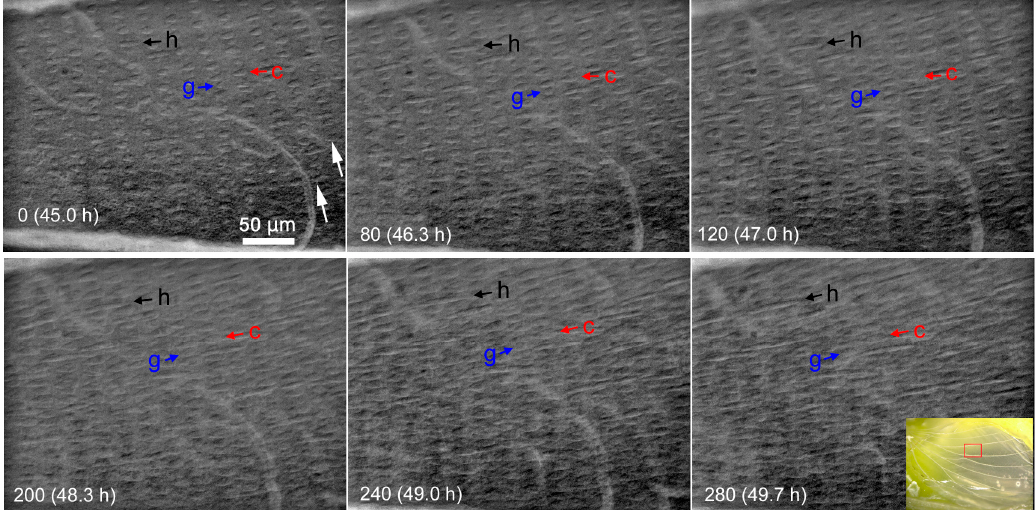
Figure 8. Scale and hair evagination in the CuA 1 compartment of the dorsal hindwing. The image recording was started at 45 h after pupation. Images were obtained every 1 min; image numbers in each panel indicate minutes after the image recording was started. Colored arrows indicate a possible cover scale (red), ground scale (blue) and hair (black), respectively. White arrows in IN0 indicate arrays of aligned scale cells. The inset shows the location of the observation on the dorsal hindwing. See also Video S5.